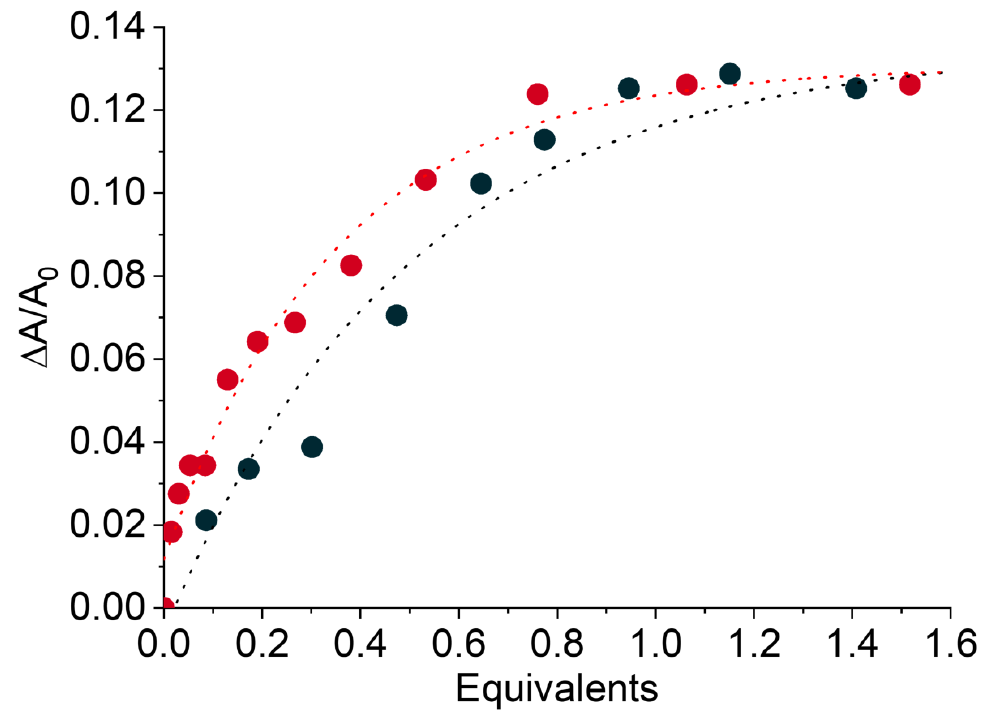
Figure 2. Comparison of relative changes in absorbance ( ∆ A / A 0 ) upon titration of I with GPS-TBA in CHCl 3 (black squares) and MeCN (red circles). ∆ A =( A max − A 0 ) / A 0 , where A max is the